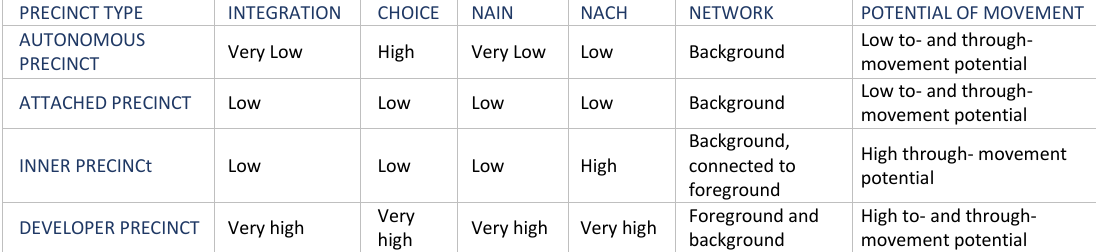
Table 4 Syntactic analysis